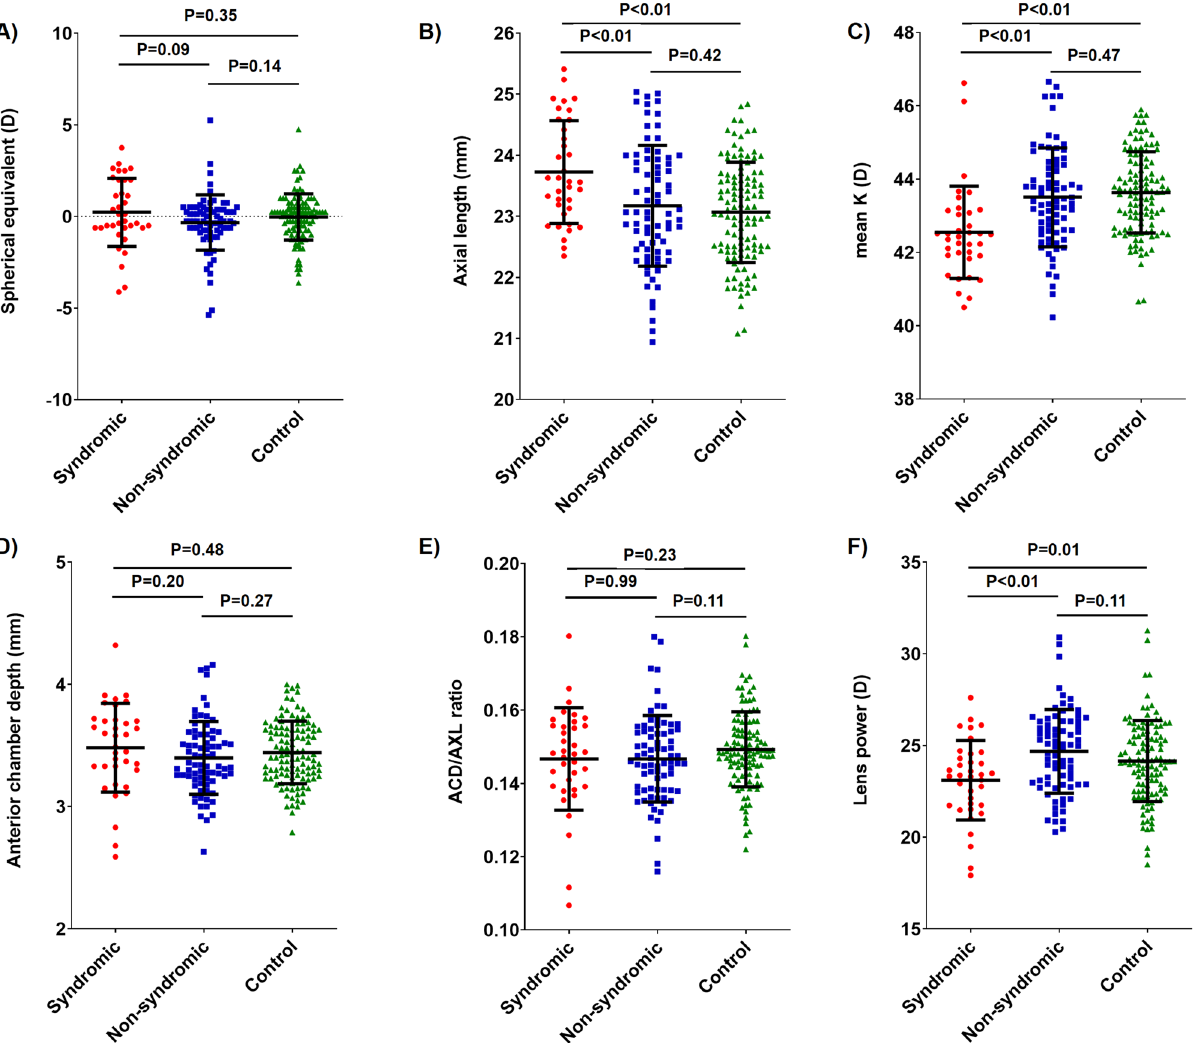
Figure 2. Comparison of biometric values between the syndromic craniosynostosis, non-syndromic craniosynostosis, and control groups. The distribution of ( A ) spherical equivalent, ( B ) axial length, ( C ) mean keratometric value, ( D ) anterior chamber depth, ( E ) anterior chamber depth/axial length ratio, and ( F ) lens power was compared between groups. ACD, anterior chamber depth; AXL, axial length; K, keratometry; NS, not significant. Error bars represent mean ±